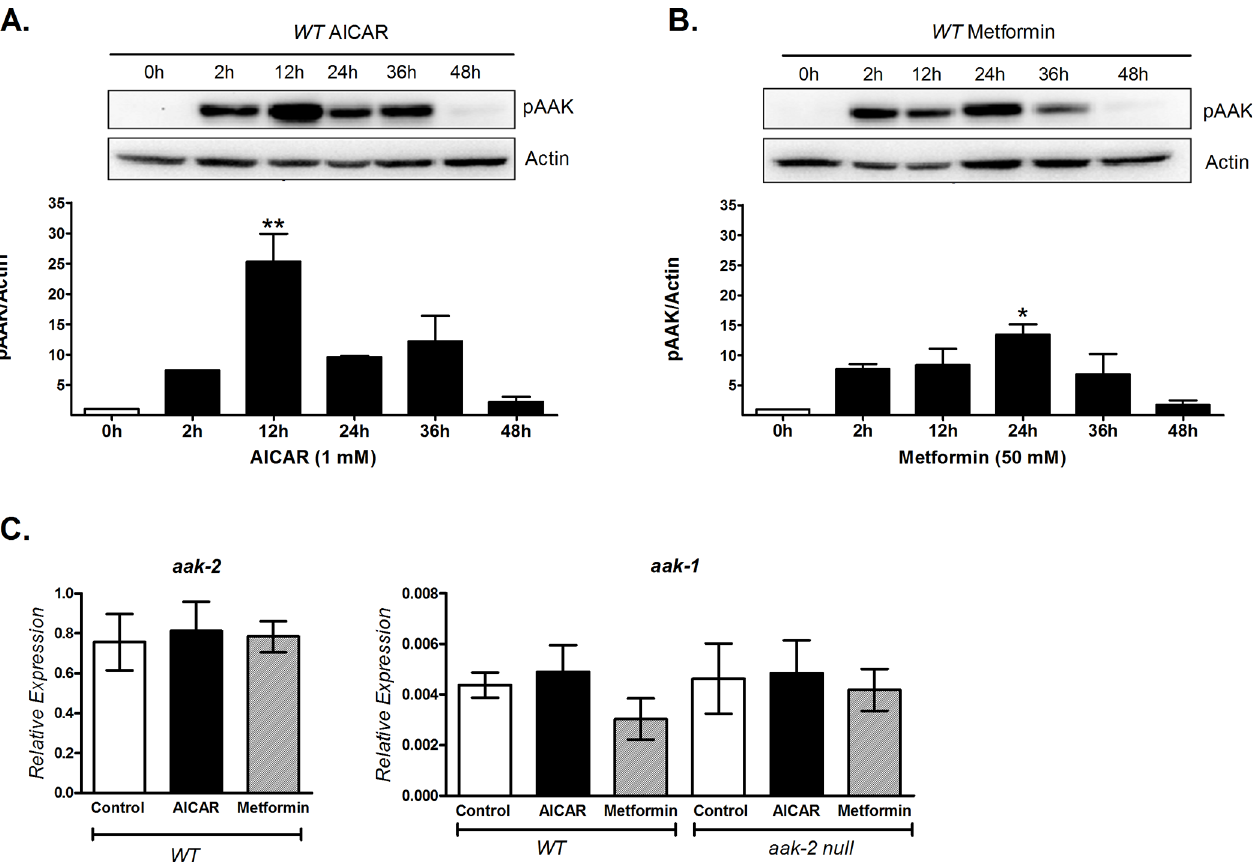
Fig 1. AICAR and metformin increased AAK phosphorylation in a time-dependent manner. AAK phosphorylation at Thr243 (equivalent to Thr172 of mammals) was detected using an anti-pAMPK antibody in N2 adult nematodes treated with A) 1 mM AICAR or B) 50 mM metformin. In both cases, the top panel shows a representative Western blot of phosphorylated AAK (pAAK), where the intensity of the bands represents the phosphorylation level, corresponding to kinase activation. C) Expression levels of aak-2 and aak-1 by qRT-PCR in N2 and aak-2/ok524 strains exposed to 1 mM AICAR for 12 h or 50mM Metformin for 24 h. The graphs show the mean ± SEM of three independent experiments * p < 0.05, ** p < 0.01 vs. 0 h, one-way ANOVA with Bonferroni's post hoc test using GraphPad Prism.